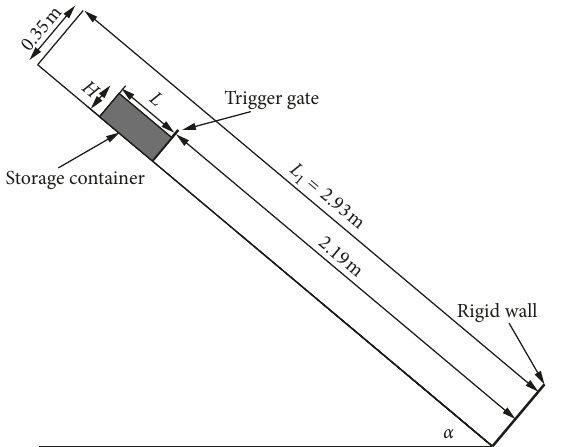
Figure 2: Sketch of the experimental equipment.